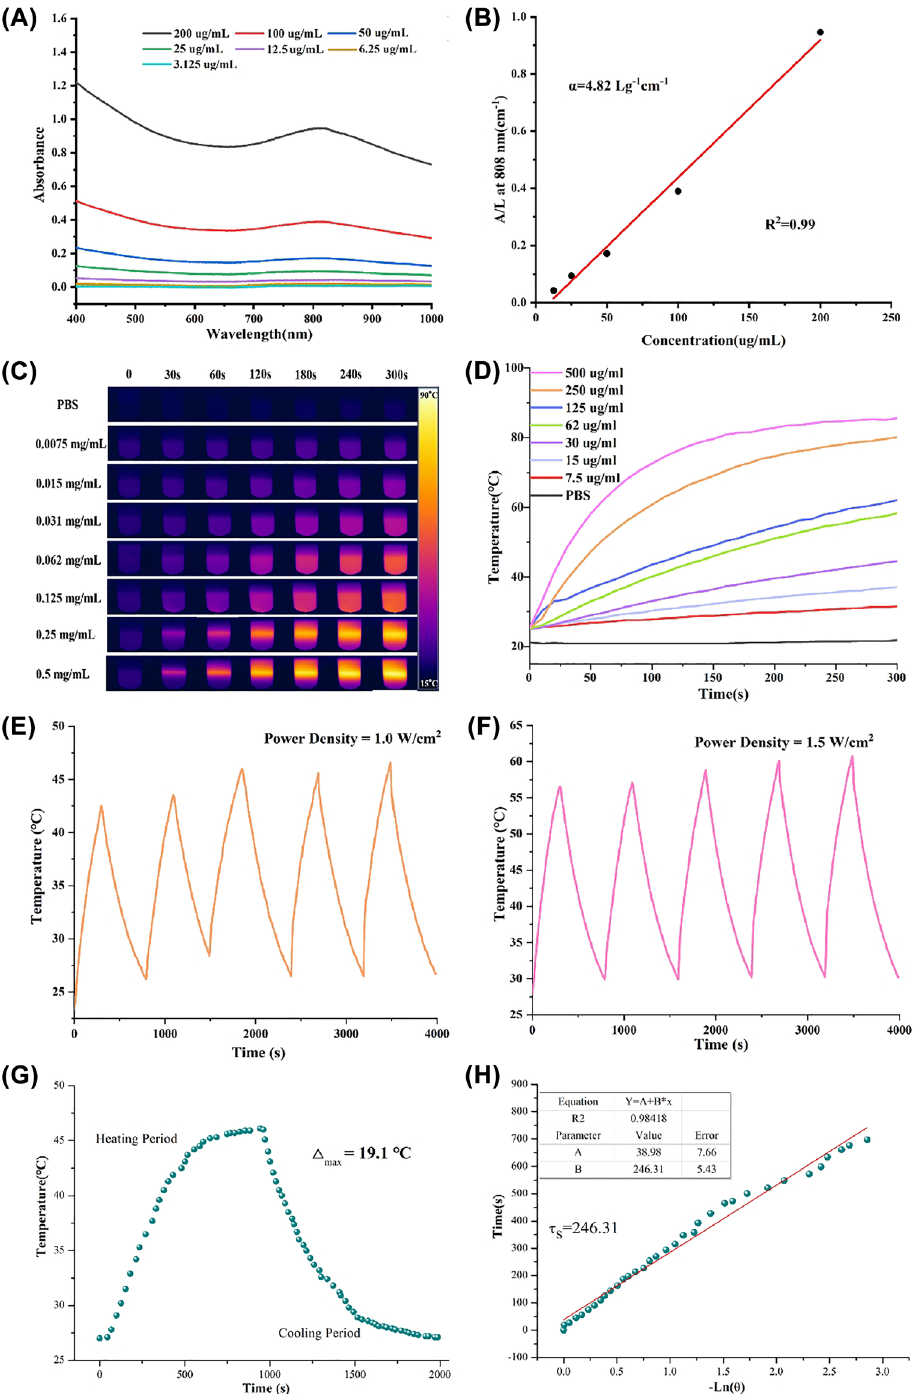
C @PEG. (A) UV-vis spectra of Mn-Ti 3 2 C @PEG at 808 nm was recommended to be calculated. (C) The photothermal 3 2 C @PEG under 808 nm laser irradiation (1.0 W/cm 2 ) for 2000 s. (H) Fitting 3 2